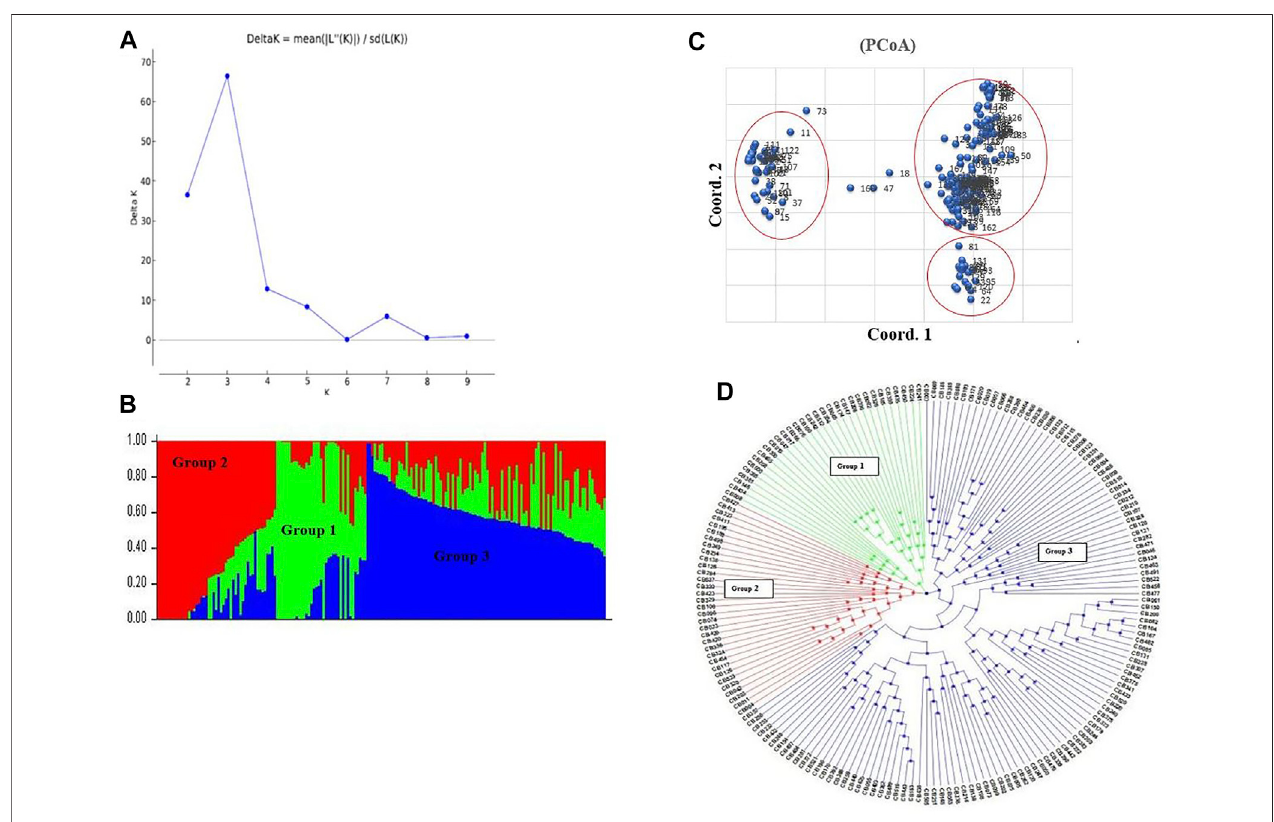
FIGURE 2 | Population structure analysis, (A) Delta K line graph, (B) structure analysis combine bar chart, (C) PCoA analysis of wheat accessions, (D) Neighbor Joining phylogenetic tree analysis.